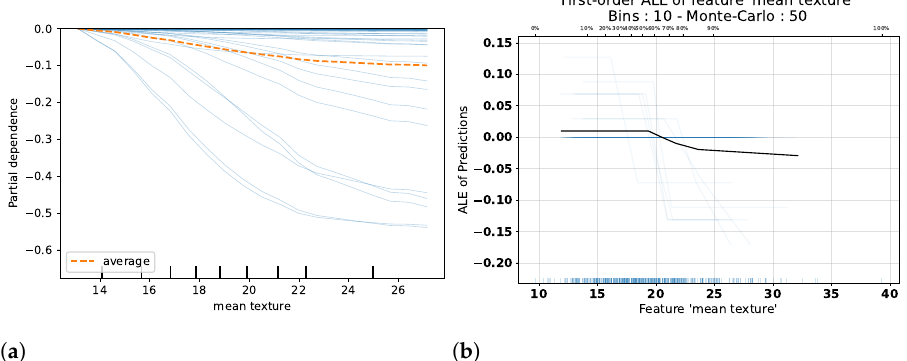
Figure 6. Examples of the visual-based XAI methods. ( a ) PDP & ICE curves. ( b ) ALE